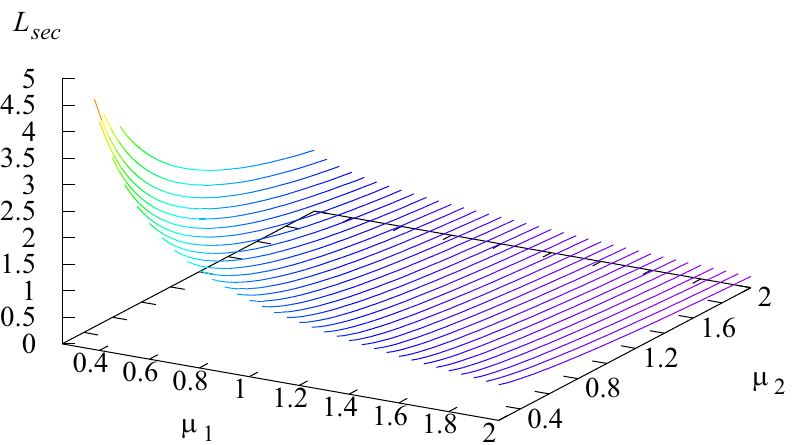
Figure 15. Dependence of the average number of customers with the secondary server L sec on the parameters µ 1 and µ 2 .